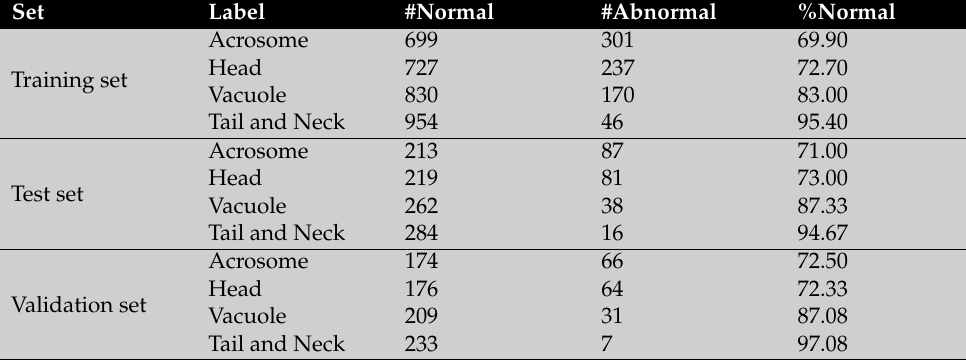
Table 3. Division of MHSMA dataset in different partitions.